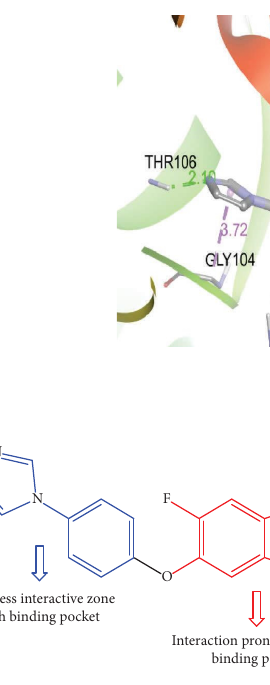
Figure 7: Probable interactive zone of benzimidazole derivatives with binding